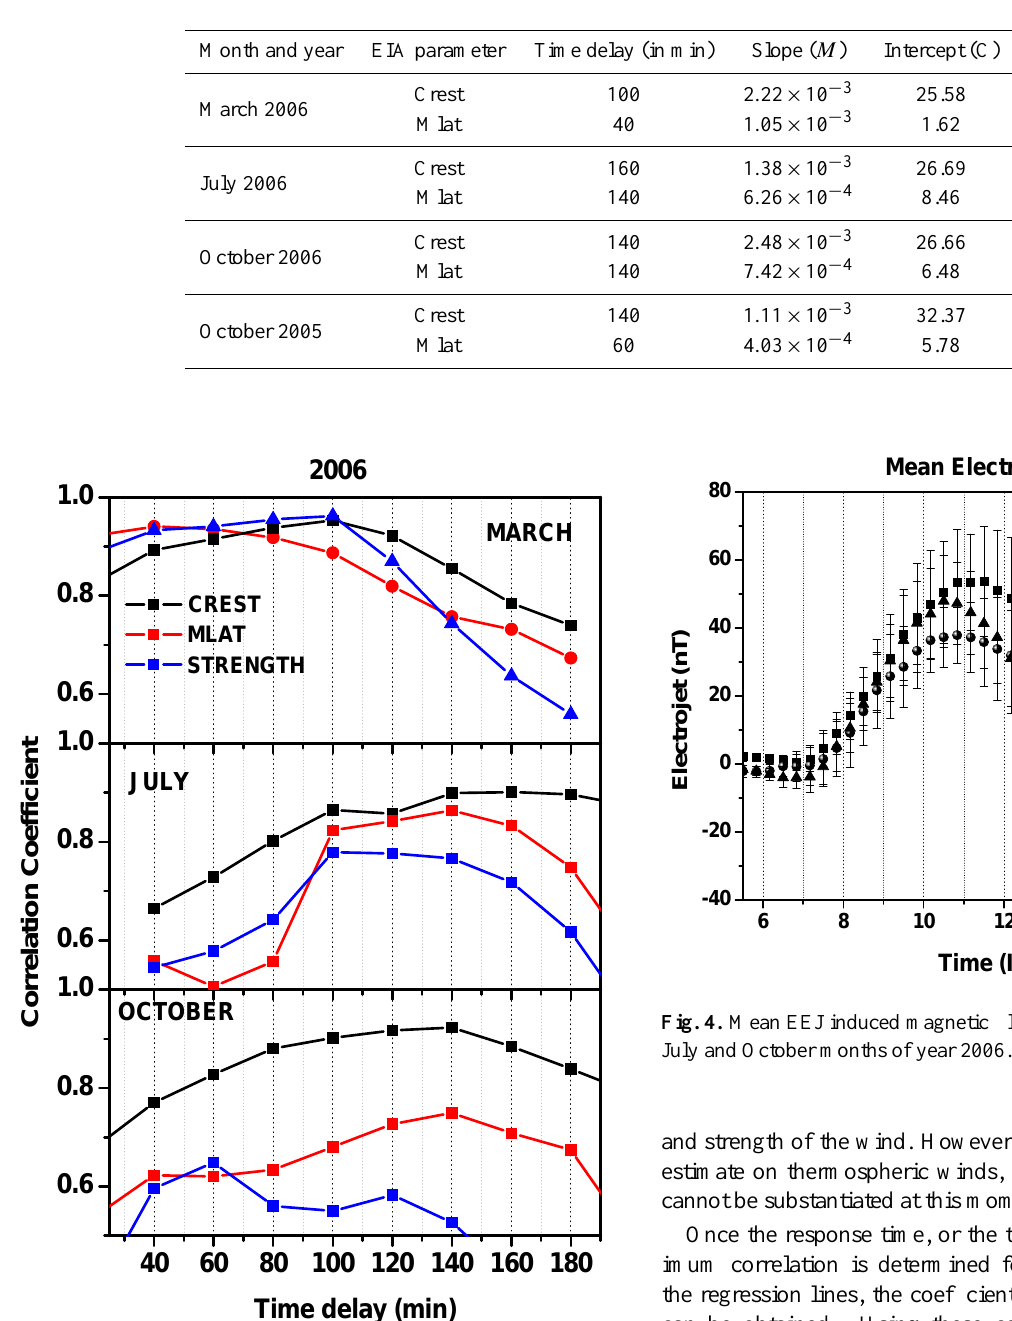
Table 1. The observed time delay and linear regression coefficients corresponding to maximum correlation obtained between EIA parameters (Crest TEC and Mlat) and IEEJ for different months.